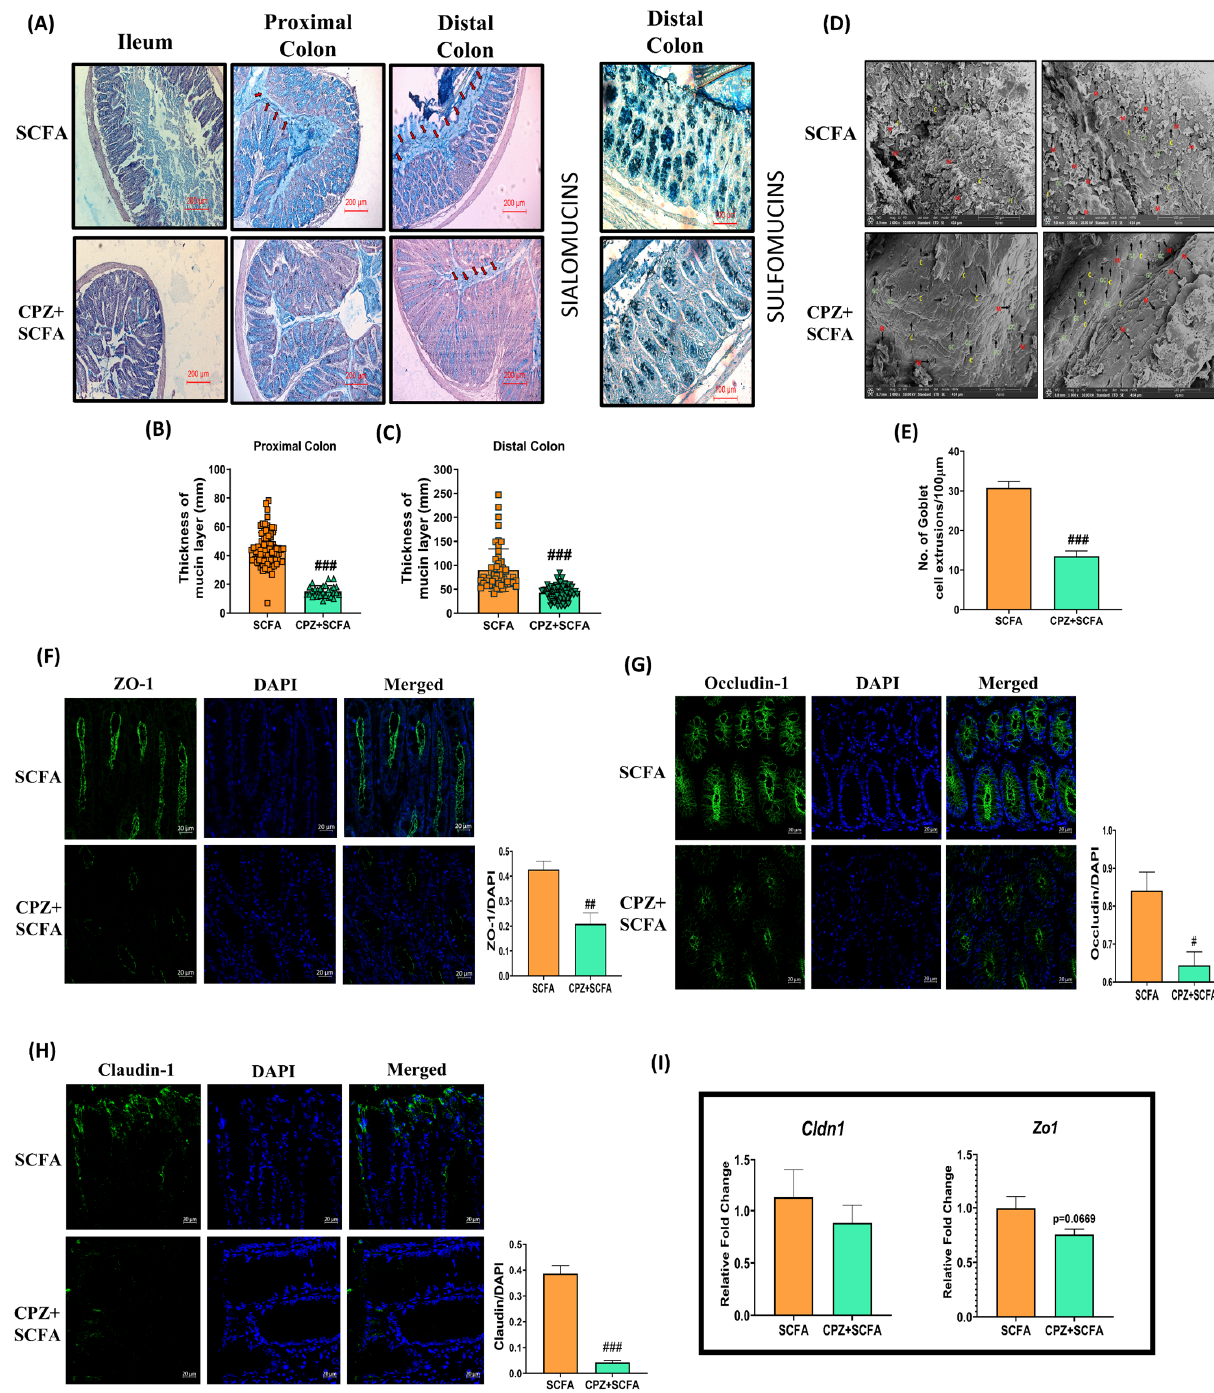
Figure 4. Effect of rectal co-administration of SCFAs on CPZ-induced alterations in colonic mucus production and tight junction proteins. Histology representative images of ( A ) Hematoxylin and Eosin—Alcian blue staining in ileum, proximal, and distal colon ( n = 3), High iron diamine—Alcian blue staining in distal colon ( n = 3), ( B ) thickness of mucus layer in proximal colon, ( C ) thickness of mucus layer in distal colon, ( D ) representative images for SEM of colon tissues, and ( E ) number of colonic mucus extrusion ( n = 3). Representative images for immunofluorescence in colon tissues for expression of—( F ) Zona occludens-1 (ZO-1), ( G ) Occludin (OCC), and ( H ) Claudin-1 (CLDN-1) along with their fluorescence intensities ( n = 3). Fluorescence intensity was measured using ImageJ and data are presented after normalization with DAPI, ( I ) gene expression analysis for tight junction